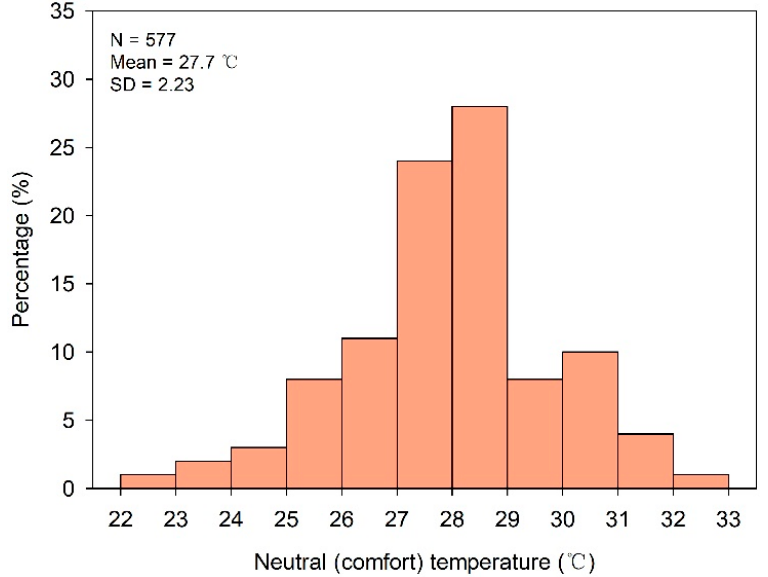
Figure 7. The frequency distribution of Griffiths neutral temperature (G = 0.5).